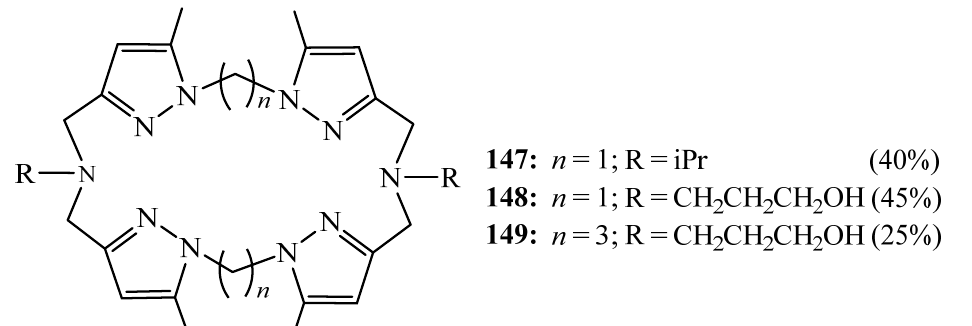
Figure 40. Tetrapyrazolic macrocycles 147 – 149 with functionalised lateral arms.